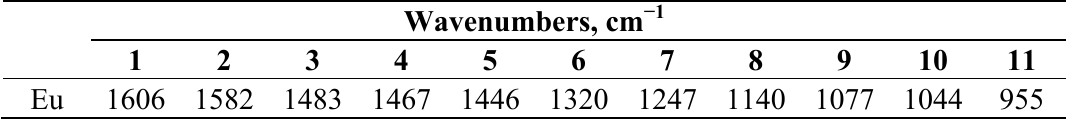
Table 3. Vibration frequencies (cm − 1 ) registered in the FTIR spectra of EuPc corresponding to the numbers assigned to the chosen bands in Figure